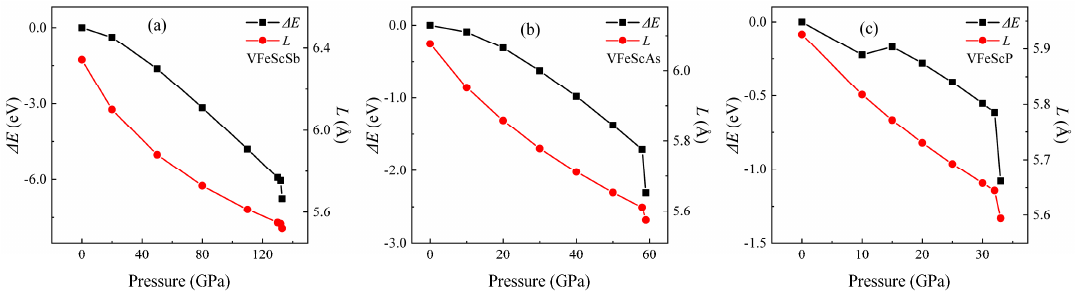
Figure 7. Lattice constant ( L ) and the energy change, ( ∆ E ) in type-I ( a ) VFeScSb, ( b ) VFeScAs, and ( c ) VFeScP as a function of pressures. ∆ E is the relative energy with respect to zero pressure.